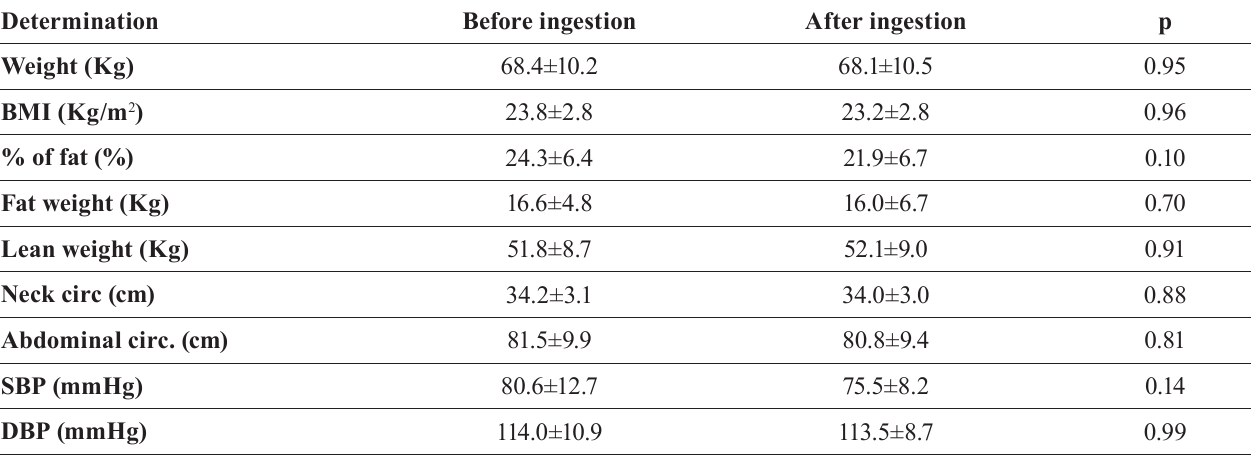
TABLE I - A nthropometric characteristics of the study population Determination Before ingestion After ingestion